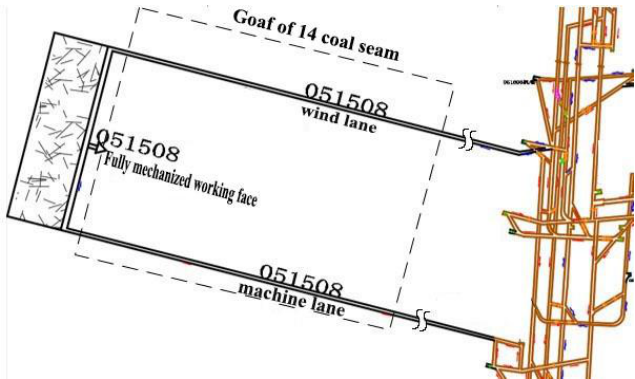
Figure 1. Layout plan of the 051508 working face.